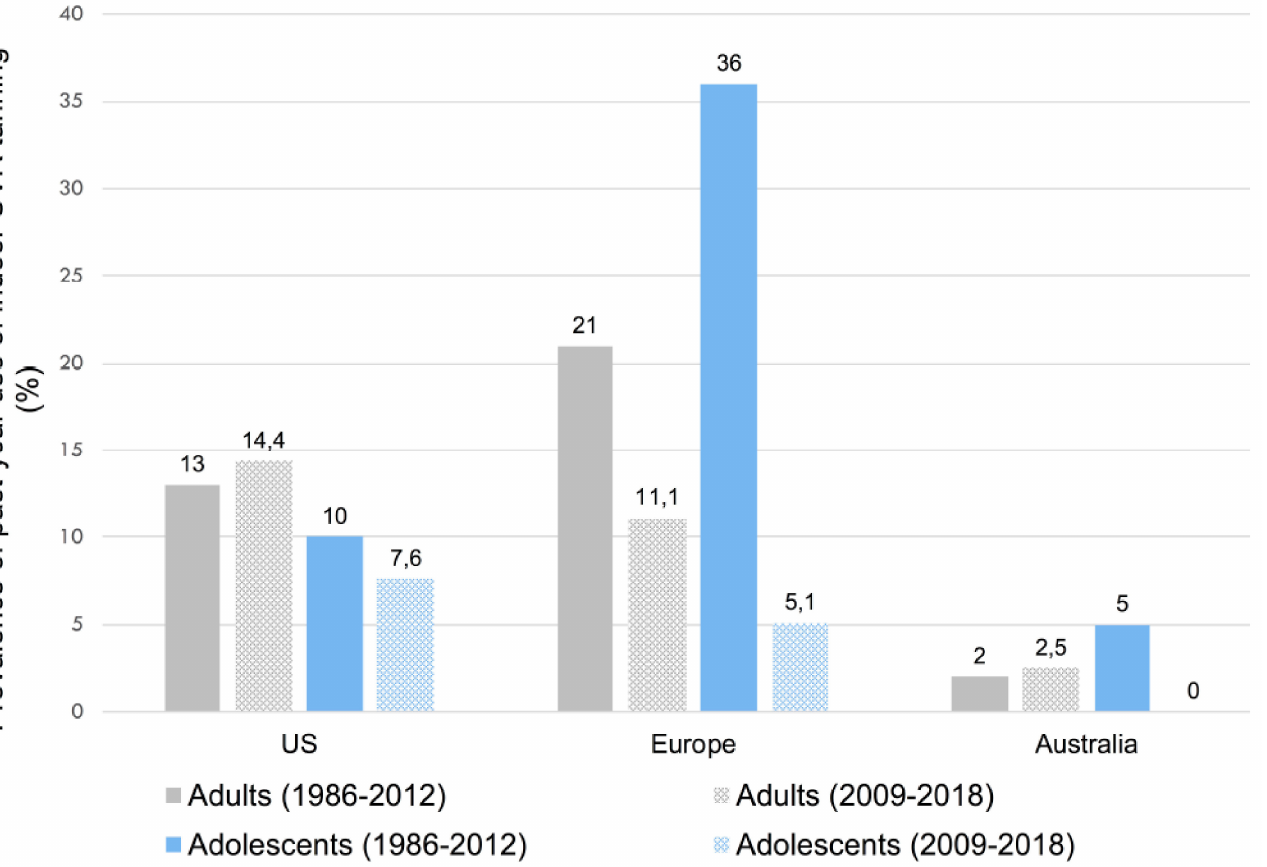
Figure 2. Summary prevalence estimates (%) reported in published meta-analyses on the past-year use of indoor UVR tanning. (The prevalence for the years 1986–2012 is reported in Wehner et al. [12], and for the years 2009–2018 in Rodriguez-Acevedo et al.